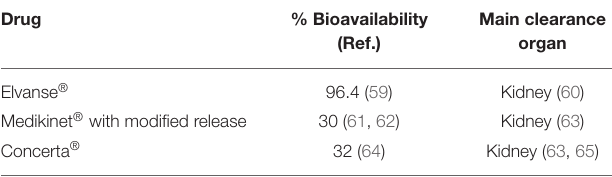
TABLE 2 | Summary of pharmacometrics information used for PBPK